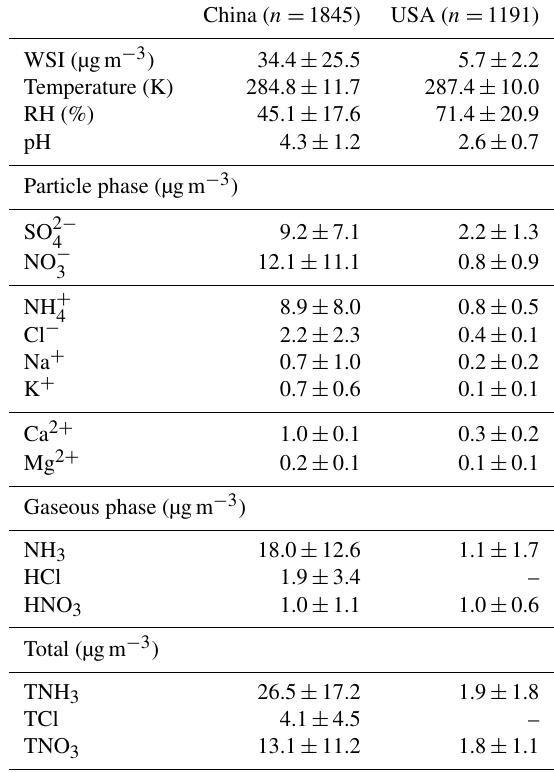
Table 1. Summary of the 1-year average values of mass concen- tration of water-soluble ions (WSI), gaseous and aerosol species, aerosol pH and meteorological parameters (as average ± standard deviation) in China and the United States during the study periods (i.e., 2017 for China and 2011 for the United